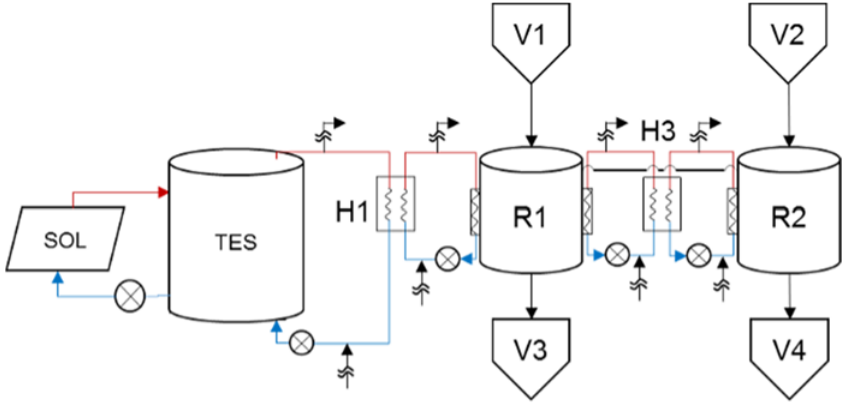
Figure 10. Plant topology for scenario (b). Table 5. Comparison of scenario solutions.